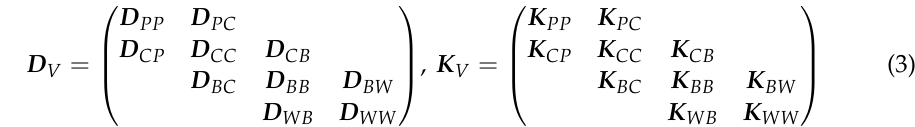
The components of the vehicle are connected by a two-stage suspension system containing springs and dampers. The nonlinear behavior of the lateral stops and lateral vibration absorber is considered. In the manuscript, the nonlinear characteristic curves of the primary vertical damping and secondary lateral damping of the vehicle are given in Figure 5. The stiffness and damping matrices can be expressed as: